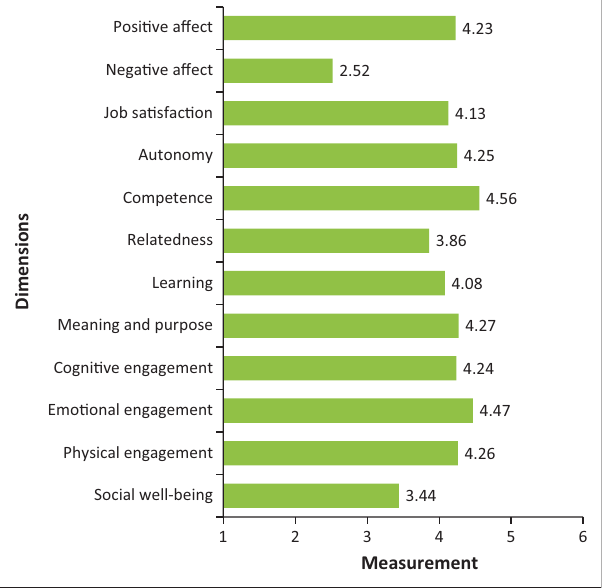
FIGURE 1: Mean scores on 12 dimensions of flourishing.